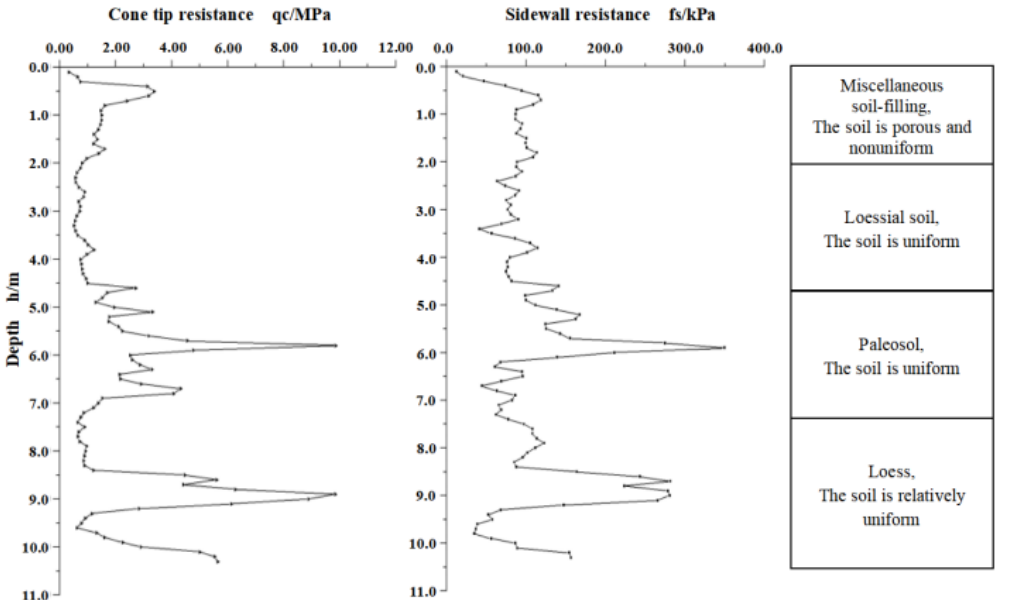
Figure 10. The curve diagram of the stress that the probe receives.